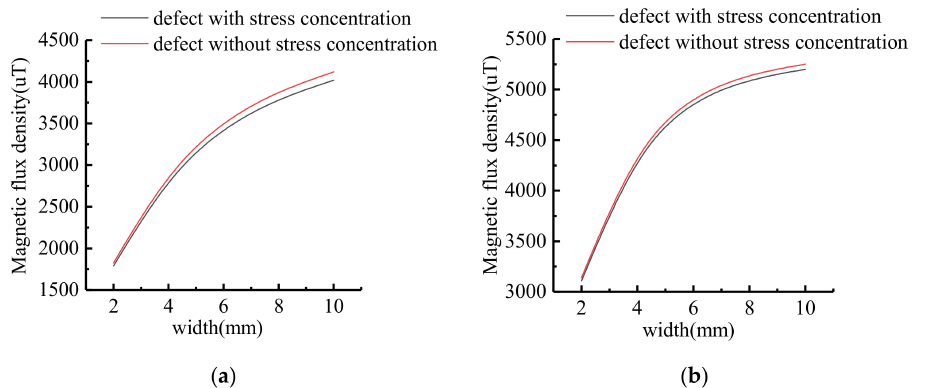
Figure 13. Comparison diagram of signal characters at different widths: ( a ) Tangential amplitude signal; ( b ) Normal peak-to-peak